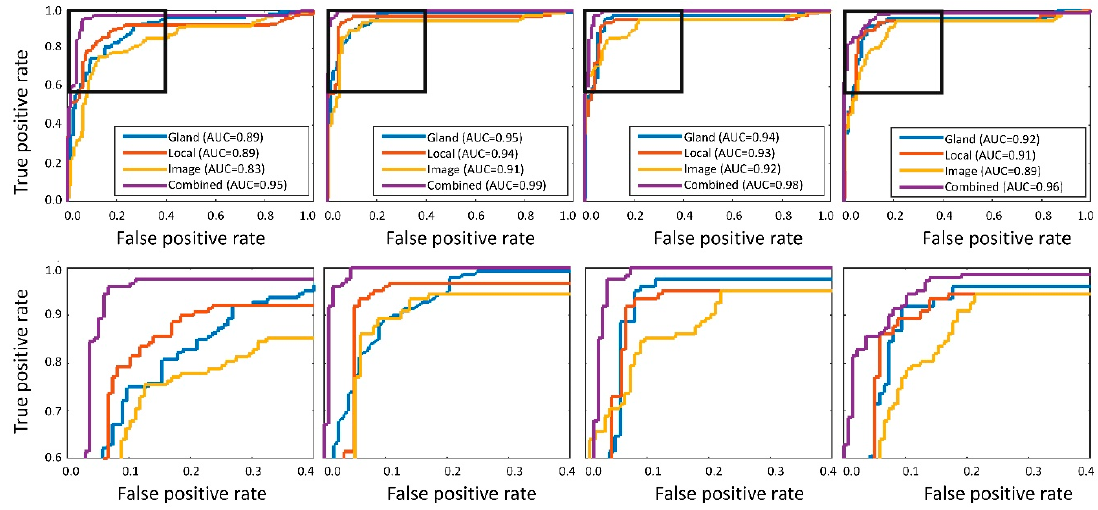
Figure 4. Top-row: Receiver operating characteristic (ROC) curve analysis and the corresponding area under the curves (AUCs) for individual feature categories and the meta-classifier. Bottom-row: zoomed in version of ROC curves. Left-to-right: Cancer detection for RMC-Dataset, cancer detection for GlaS-Dataset, cancer grading for RMC-Dataset, and cancer grading for GlaS-Dataset.